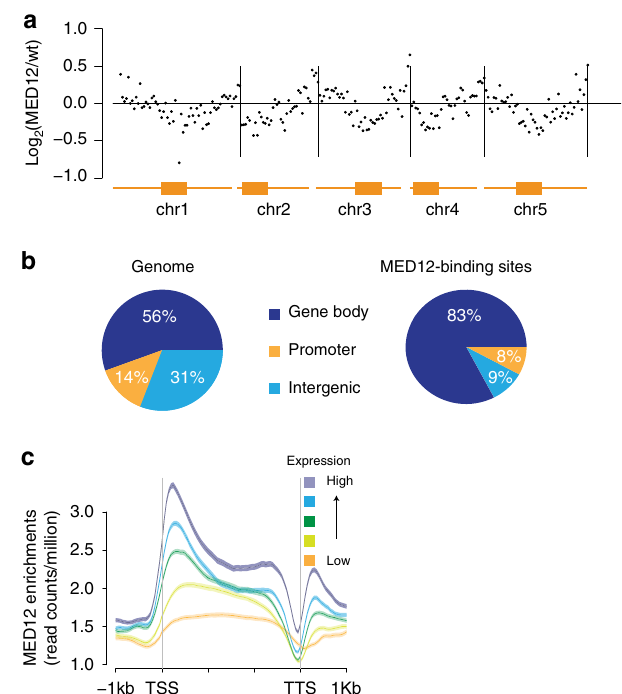
Fig. 5 Characterization of MED12-enriched loci. a Genome-wide distribution of MED12 on fi ve chromosomes (chr). Each of the fi ve Arabidopsis chromosomes was divided into 500-kb window. The relative enrichments of MED12 within each window was plotted. Y -axis represents the log 2 value of MED12-ChIPseq reads in MED12 complementing plants relative to those in wild-type plants. Orange rectangles indicate the locations of pericentromeric regions. b The distribution of MED12 ChIP-seq peaks overlapping with different genomic features (right). The background distribution of different genomic features is shown on the left. c Average distribution of MED12 over genes of different expression values. All expressed genes were divided evenly into fi ve groups based on their expression levels in wild-type plants. Orange to yellow to green to blue to purple is low-to-high expression tiers. Y -axis represents MED12-FLAG ChIP-seq read counts normalized to sequencing depth. − 1 kb and 1 kb represent 1 kb upstream of transcription start site (TSS) and 1 kb downstream of transcription termination site (TTS),